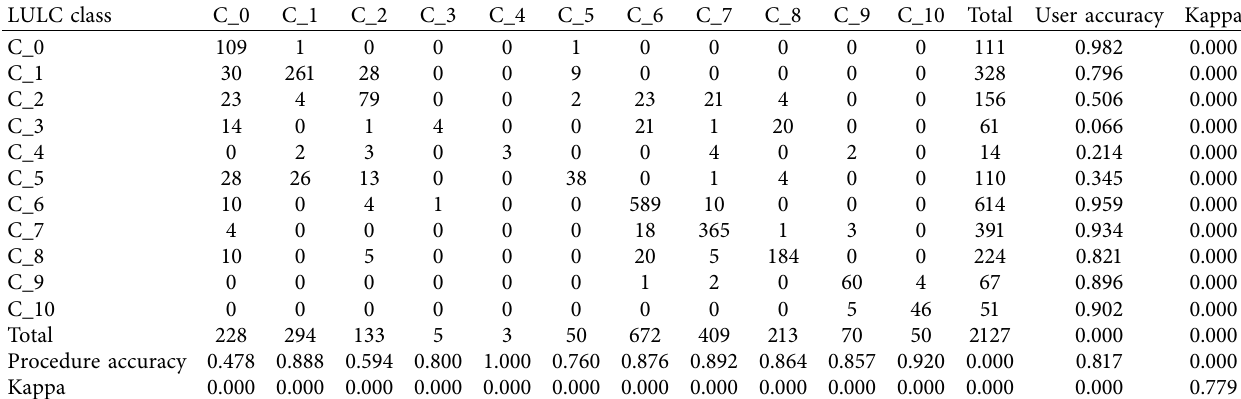
Table 3: Result of the accuracy assessment for the LULC classification based on the ML classifier with the MaSegFil